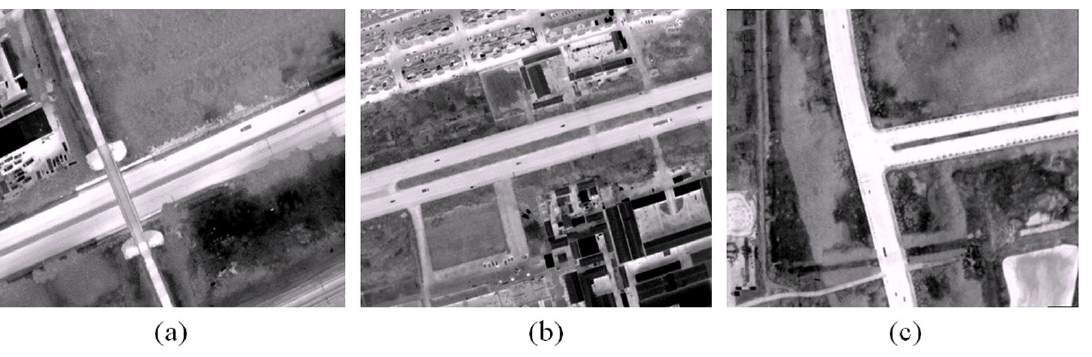
Figure 4. Images in the experimental sequences after pre-processing: ( a ) the 50th frame of Sequence A; ( b ) the 50th frame of Sequence B and ( c ) the 50th frame of Sequence C.